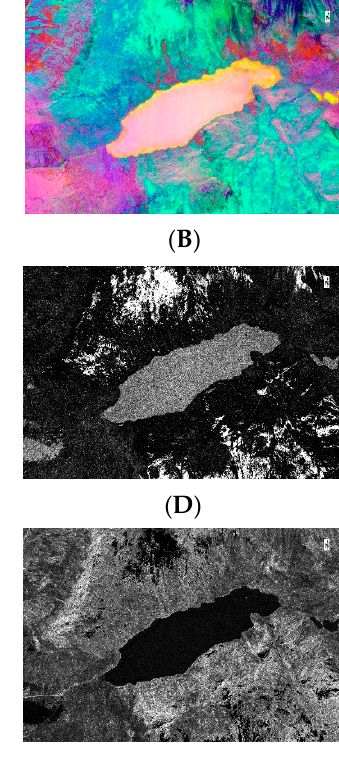
Figure 9. ( A ) Absorption characteristics of the continuum removal spectra of Lujavrite; ( B ) Characterization of the in situ spectra of Lujavrite. Table 3. Spectral absorption characteristics of lujavrite.